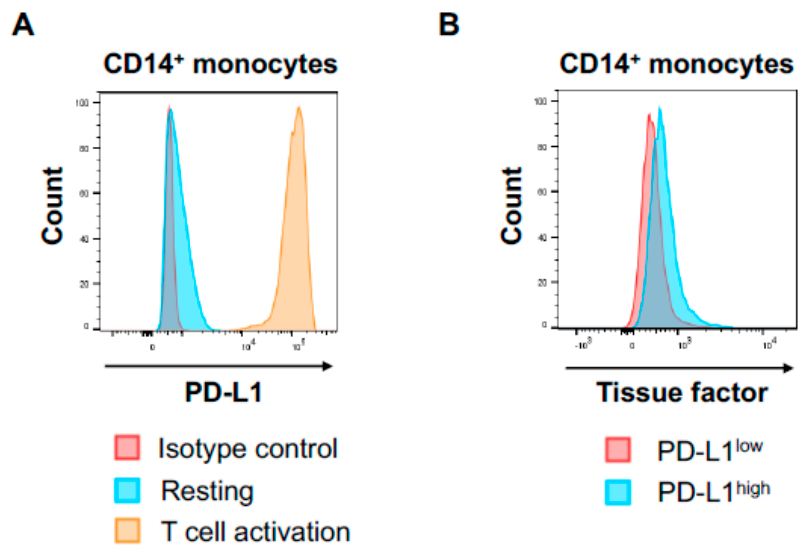
Figure 4. T cell activation increased PD-L1 on monocytes and PD-L1 high monocytes expressed higher TF compared with PD-L1 low monocytes. ( A ) Histogram of PD-L1 expression in CD14 + monocytes under resting condition or cultured with CD3 / CD28 / CD2 beads. ( B ) Histogram of TF in PD-L1 high and PD-L1 low CD14 + monocytes cultured with CD3 / CD28 / CD2 beads.